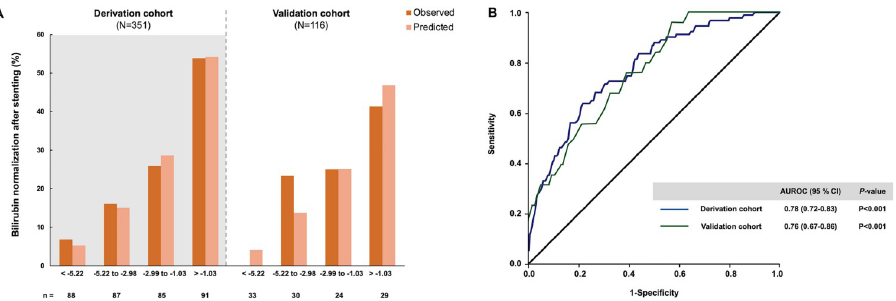
Fig 2. The probability of bilirubin normalization and diagnostic accuracy of the risk score in the derivation and validation cohorts. (A) The observed and predicted rates of bilirubin normalization after endobiliary stent placement according to the approximate quartiles of the risk score. (B) The area under the receiver operating characteristic curve of the risk score for predicting bilirubin